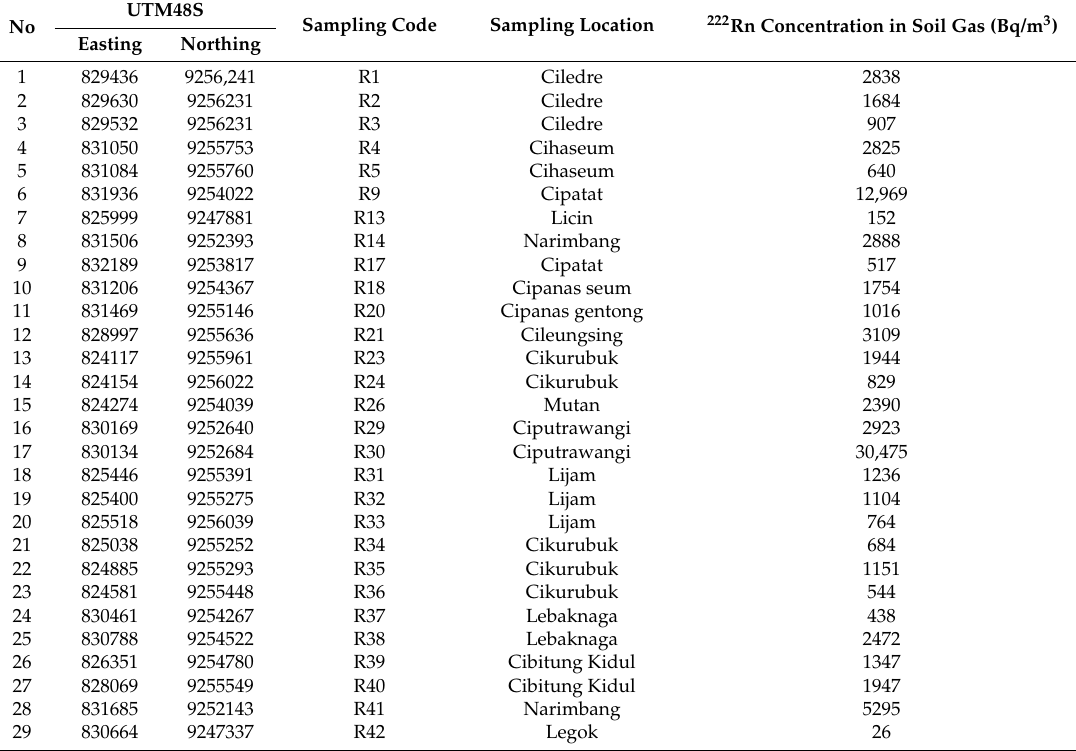
Table 10. Soil-gas 222 Rn concentration in Tampomas and the surrounding